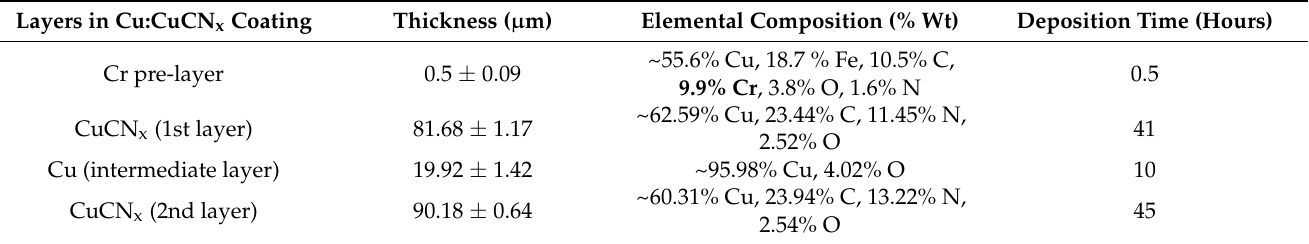
Table 6. Thickness and EDS elemental composition of different layers of the Cu:CuCN x coating. Five measurements were conducted for each thickness.